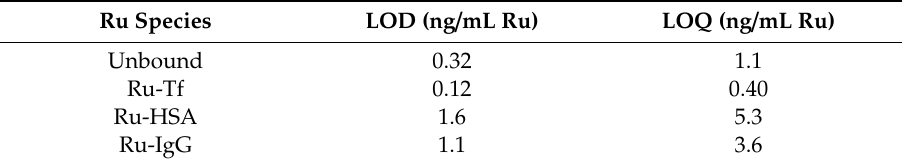
Table 3. Limits of detection (LOD) and limits of quantification (LOQ) for separated Ru species on the CLC monolithic column with ICP-MS